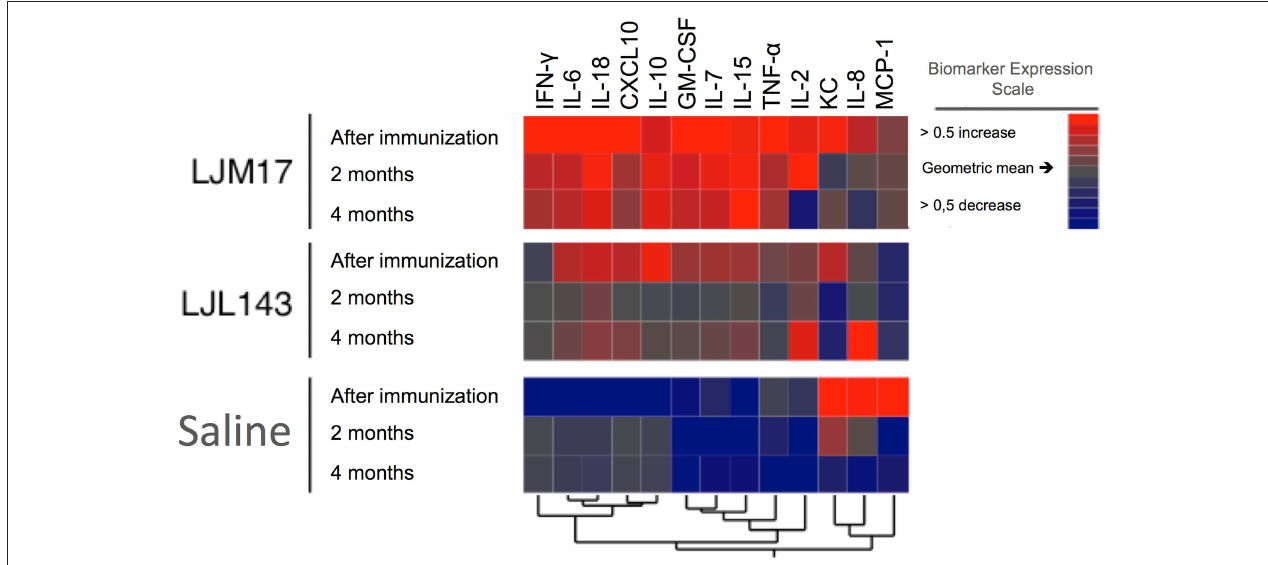
FIGURE 5 | Cytokine and chemokine expression profiles in immunized dogs and controls. Beagle dogs (n = 10 animals/group; total of 30 dogs) were immunized following the vaccination strategies described in the methodology section. Thirty days after the final immunization, dogs were challenged with L. infantum in the presence of L. longipalpis saliva. Immunized and control animal sera were collected after immunization (T0) T1 and T2 (2 and 4 months after infection) to detect cytokines and chemokines. The hierarchical cluster analysis expression scale is representative of a relative change from the geometric mean of the entire study population ( n =